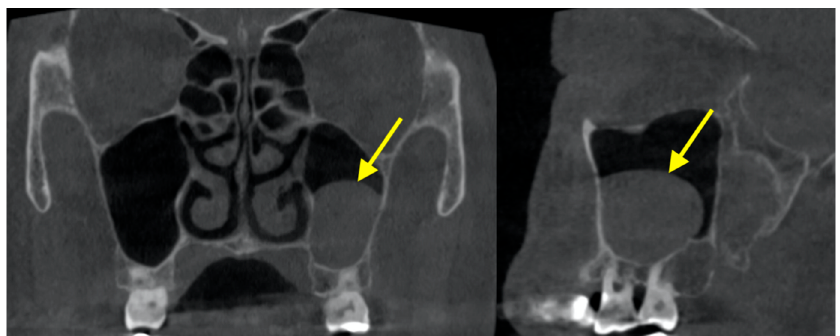
Figure 5. Mucous retention cyst in the left maxillary sinus.